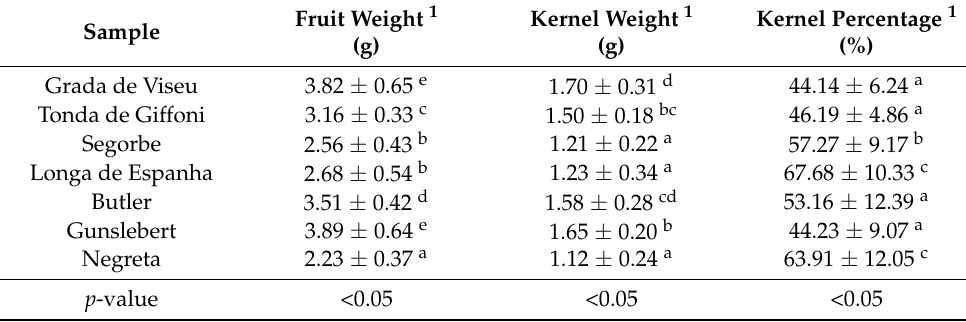
Table 1. Weight of the hazelnut fruits and kernels (mean ± standard